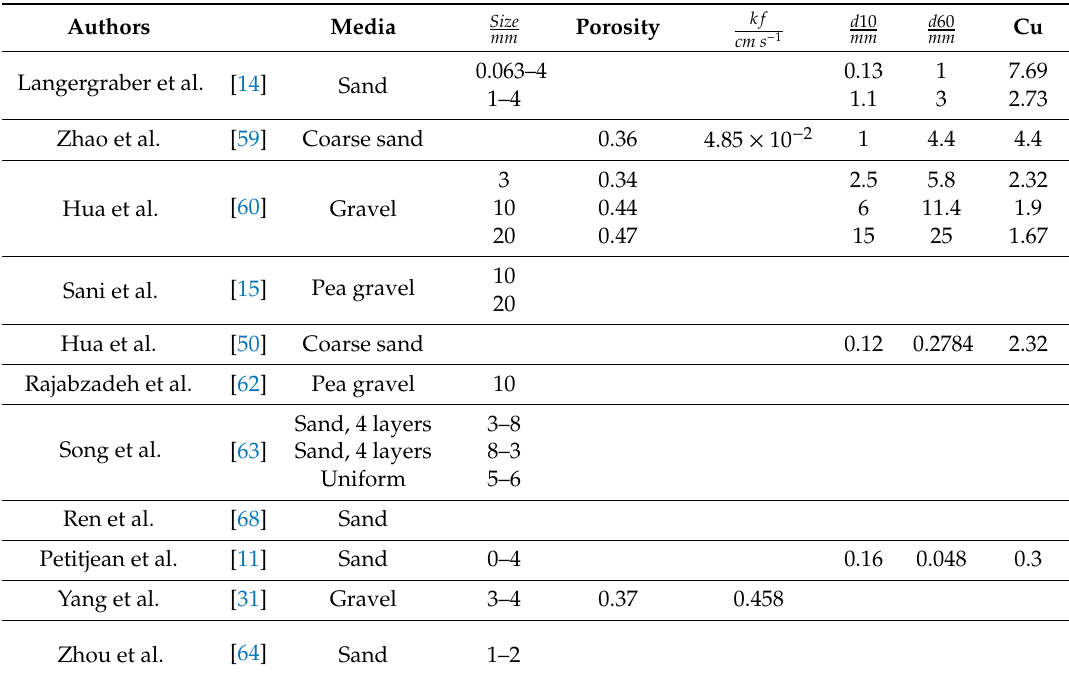
Table 5. Description on the filter media used in the described